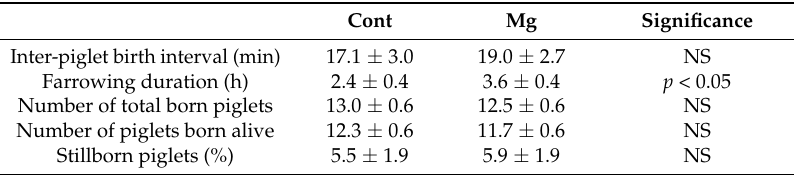
Table 2. Measurements (mean ± s.e.m collected from the sow at farrowing, fed either standard lactation diet (Cont) or those supplemented with 21 g/day MgSO 4 (Mg).